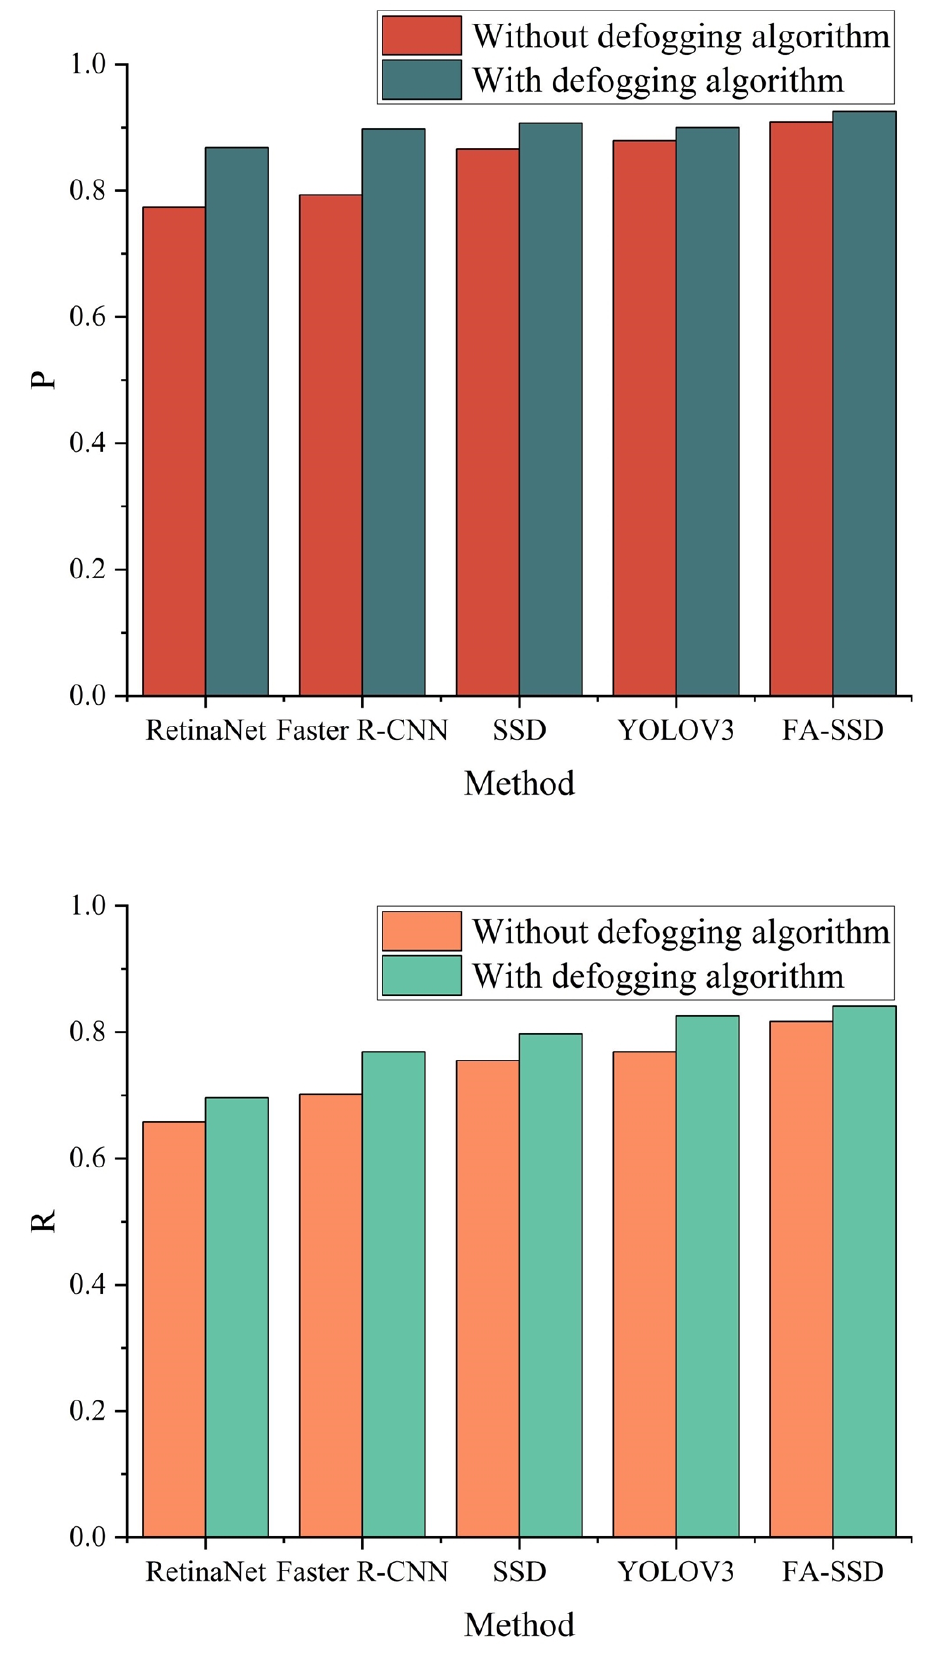
Figure 12. Experimental results before and after adding the defogging